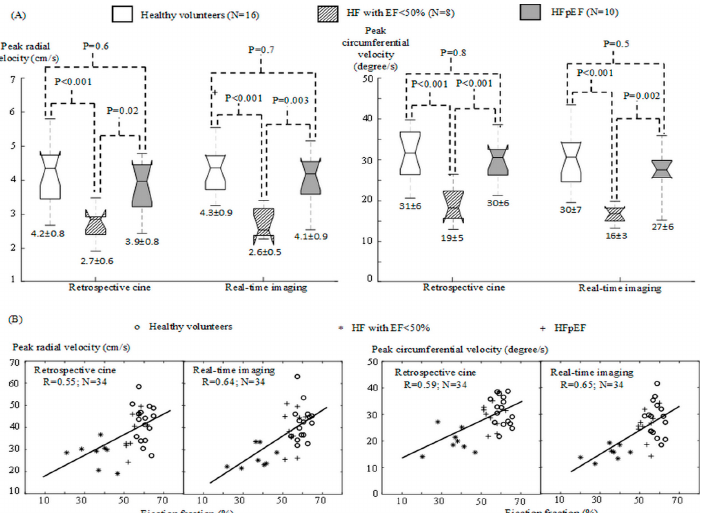
Figure 4. Peak velocity measurements with retrospective cine and real-time imaging in the healthy volunteers and HF patients. ( A ) Box plots for peak radial and circumferential velocity measure- ments in retrospective cine and real-time images. The numbers above the boxes provide P values from one-way ANOVA statistics and those below the boxes are the mean and standard deviation in each subject group. ( B ) Pearson correlation coefficients between peak velocity measurements and EF in retrospective cine and real-time images. Figure 5 provides examples of the correlation analysis between radial and circumfer- ential velocity measurements, respectively, in a healthy volunteer, in a HF patient with EF < 50%, and in a HF patient with preserved EF. It was found that the correlation between radial and circumferential velocity measurements was positive in the basal slices with clockwise rotation and negative in the apical slices with counter-clockwise rotation. The correlation calculated from retrospective cine images was not considerably different